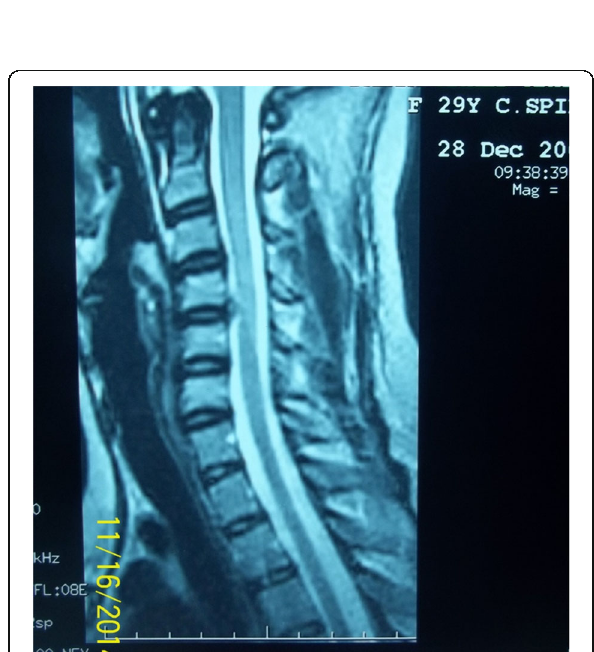
Fig. 7 Preoperative MRI sagittal